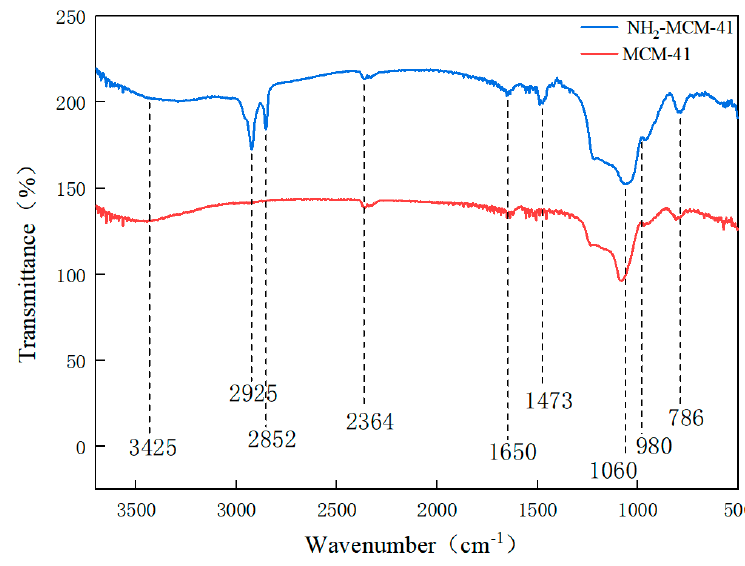
Figure 7. FT-IR diagram of MCM-41 and NH 2 -MCM-41.